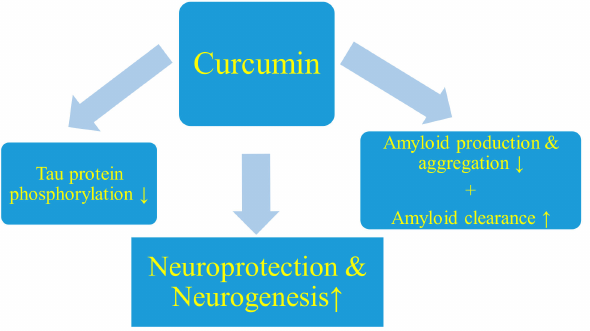
Figure 1. The likely e ff ect of curcumin on post-ischemic neurodegeneration. ↓ : Decrease. ↑ :